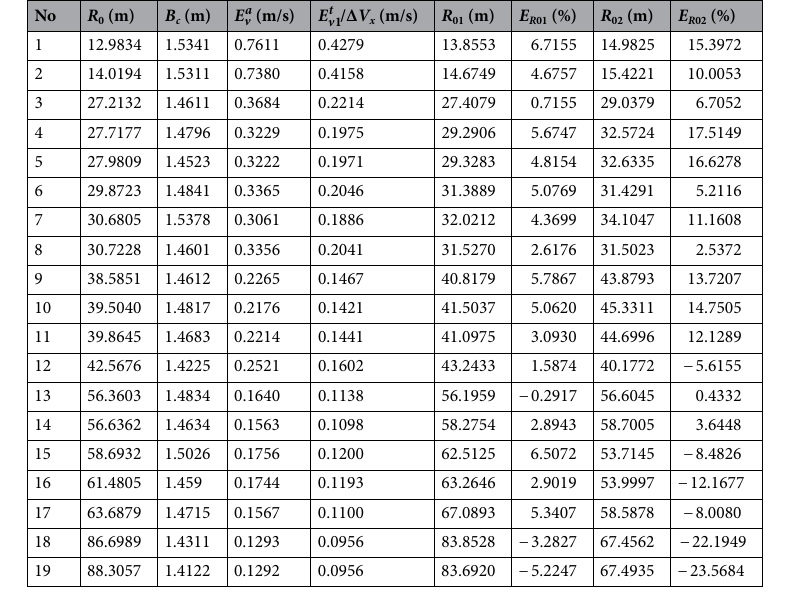
Table 6. Calculation results from model and curve